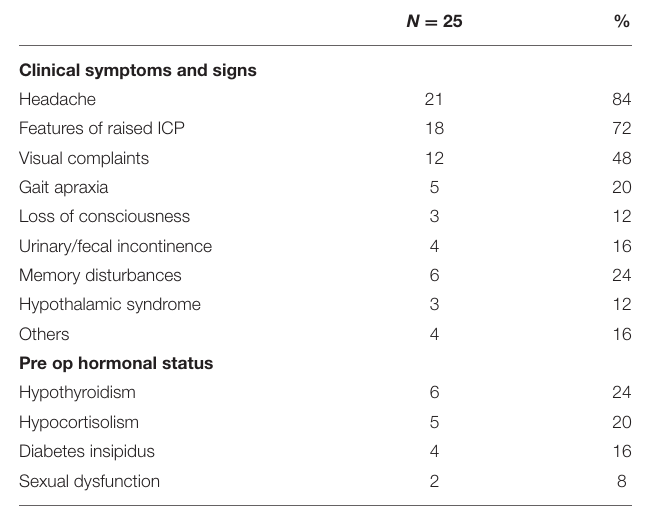
TABLE 2 | Clinical presentation.